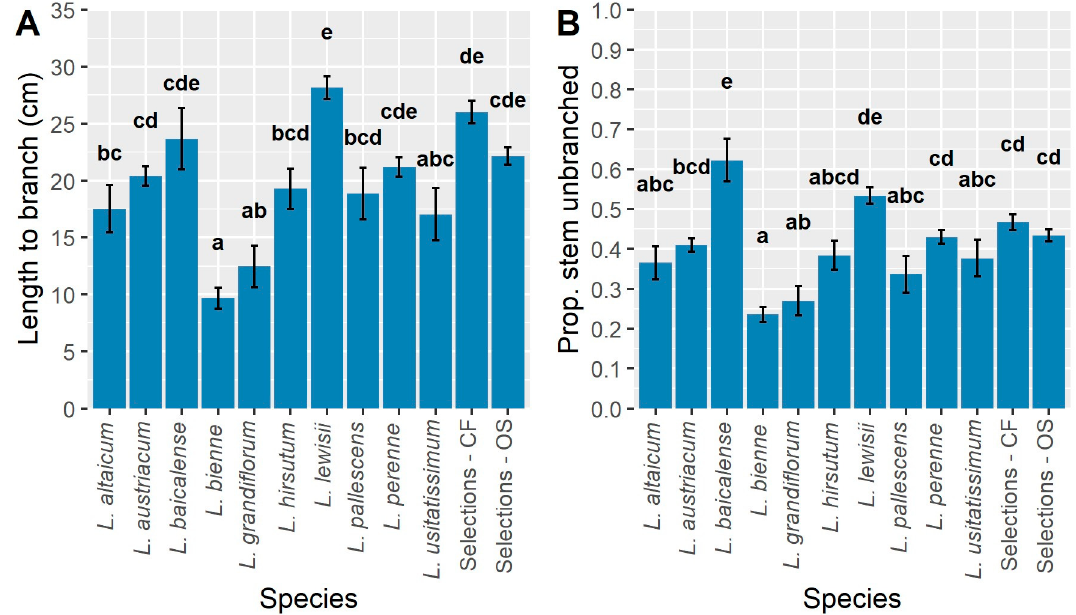
Figure 9. Comparison of wild flax ( Linum ) species with CF and OS selections for mean ± S.E. Year 1 trait values related to the CF ideotype and would also be useful for future fiber length determinations: ( A ) length to first branch > 5 cm (cm) and ( B ) proportion of stem unbranched. Means separations (letters above the bars; 5% HSD) denote significance.